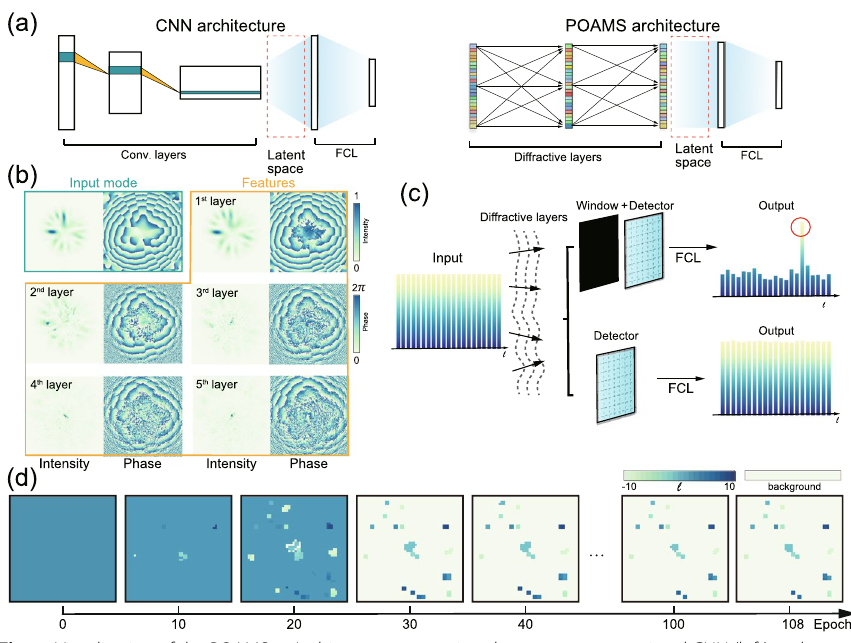
Fig. 5 Visualization of the POAMS. a Architecture comparison between a conventional CNN (left) and the POAMS (right) for further model interpretation. The red dashed rectangles represent the latent space connecting electronic convolutional layers (or optical diffractive layers) and FCLs. b Visualization of the complex optical features behind each diffractive layer. Intensity distributions are normalized. It can be seen that the diffractive layers can mix and redirect the spatial wavevectors ‘intelligently’. c The visualization workflow for searching the specific spatial regions in the detector plane that connects corresponding TC number. Window size (white box size): 2 × 2, stride size: 1. d Evolution of obtained characteristic graphs during training. Colormap encoded with TC number. Model at #108 epoch is the best model (with the lowest validation